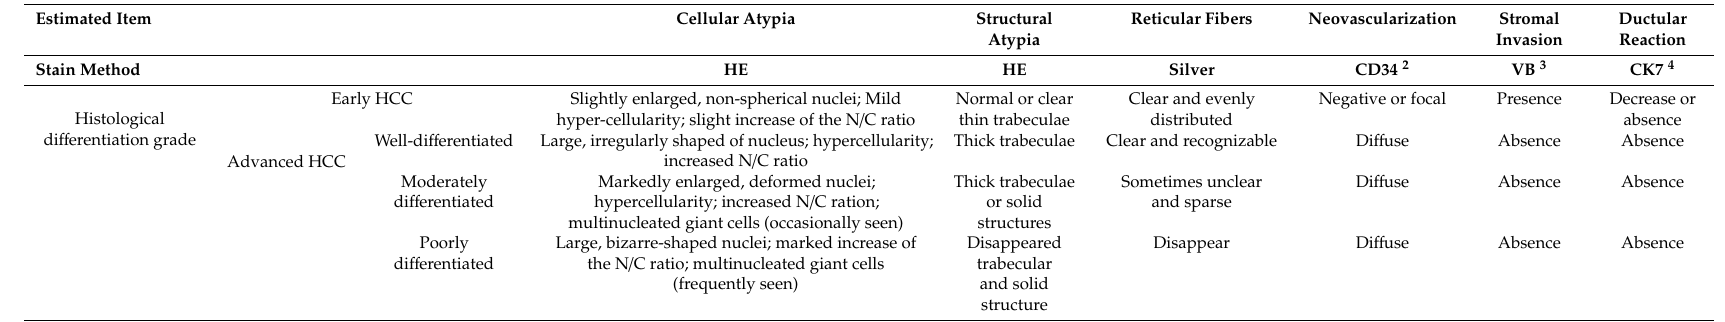
Table 1. Our histological criteria for diagnosis of the di ff erentiation grade of HCC 1